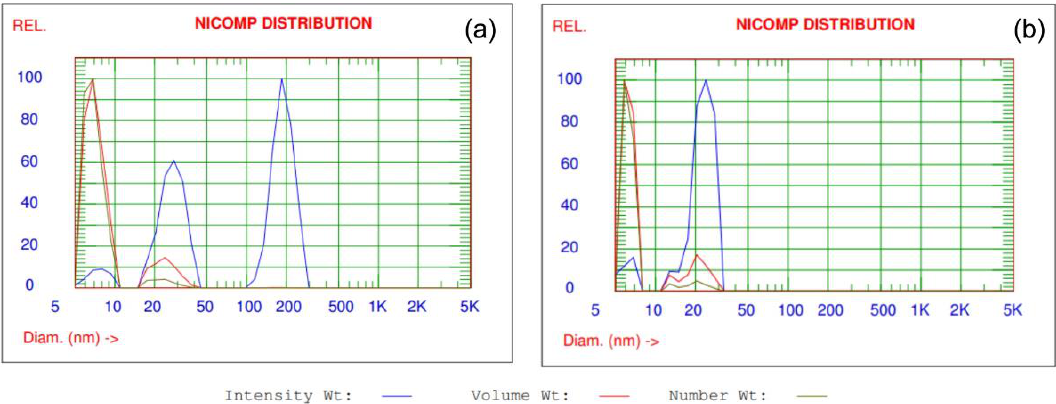
Figure 3. Nicomp distribution analysis of the intensity-, volume- and number-weighted data collected for ( a ) ZnO and ( b ) TiO 2 NPs in commercial dispersions.